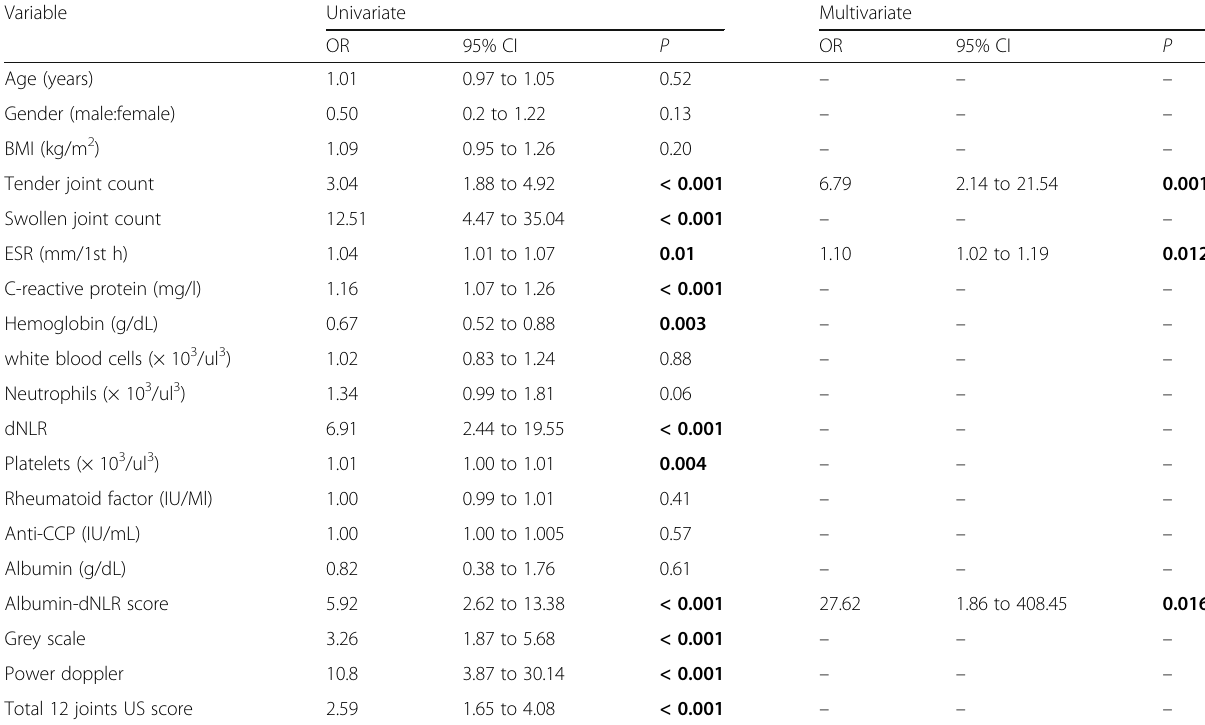
Table 4 Logistic regression analysis for predictors of disease activity using DAS28 among rheumatoid arthritis patients Variable